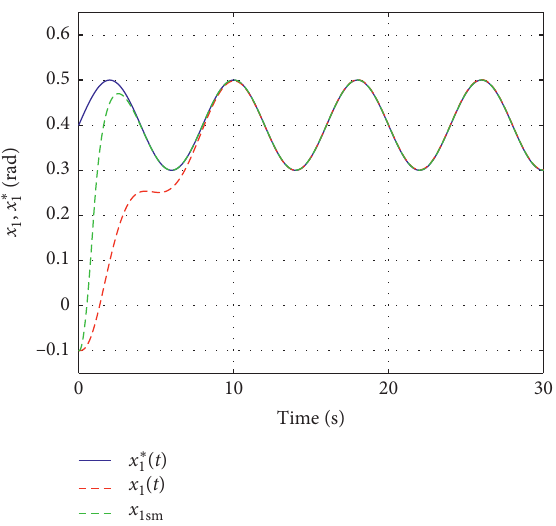
Figure 9: Comparison results for sinusoidal trajectory